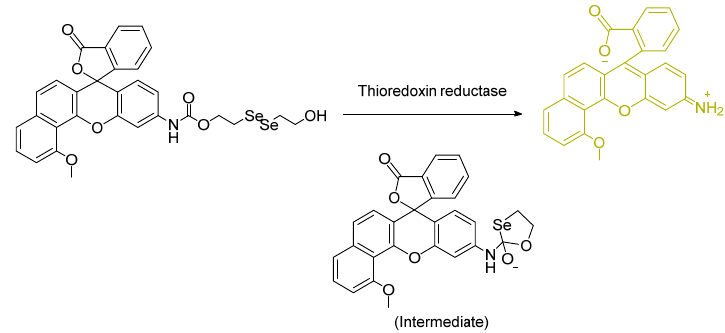
Figure 12. The first TrxR diselenide–based probe reported by Mafireyi, et al.